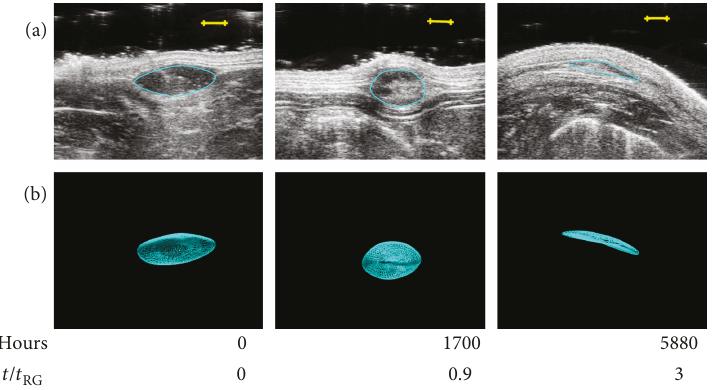
Figure 7: Ultrasound analysis of implants. (a) 2D images of microsphere implants, with the degradation crosslink modulator -CN ( ε -Lys), showing the widest cross-section at 0, 1700, and 5880 hours post injection, and the time relative to in vitro reverse degelation time ( t / t RGin vitro ). Scale bars = 2 mm. (b) 3D USCT renderings showing the volumes of the implants shown in (a).